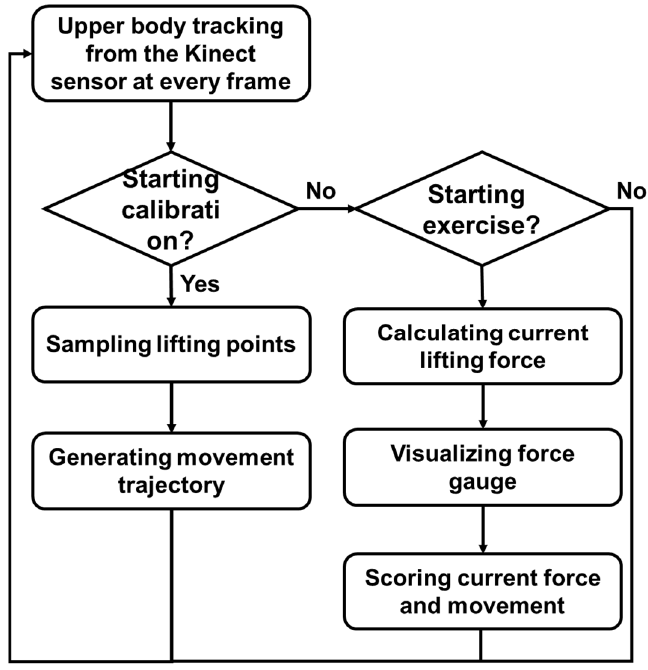
Figure 8. Process for the personalized weight perception interface.